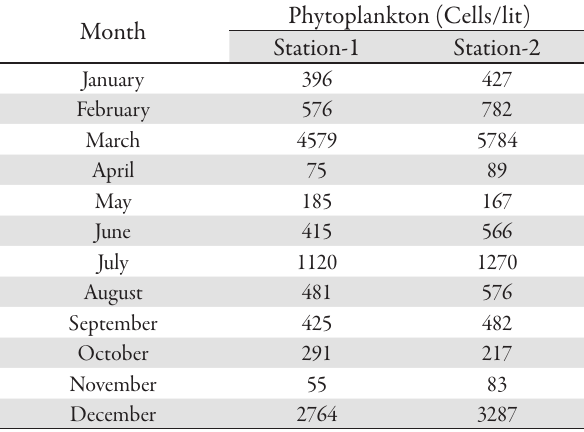
Diplopsalis sp. Tab. 4. Seasonal changes in the abundance of total phytoplankton in Station-1 and 2